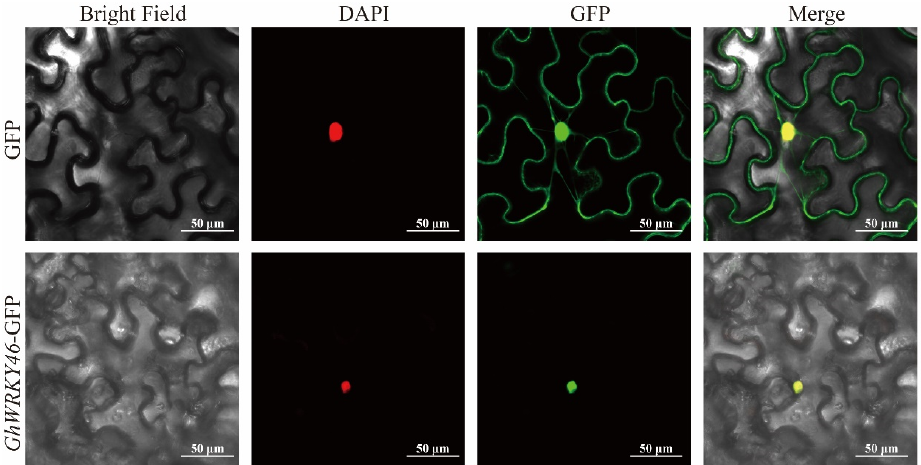
Figure 6. Subcellular localization of the fused GhWRKY46 in tobacco leaf cells. The 121-GFP was used as the control. Nuclear DAPI staining was expressed in the same cell. The scale bar is 5 µm. The cotton lines transformed with the pTRV2:: CLA1 show an albino phenotype, in- dicating that the VIGS experiment was successful (Figures 7b and 8b). The expression level of GhWRKY46 in the silent plants was significantly lower than in the pTRV2:: 00 plants (Figures 7c and 8c). Three weeks later, the silenced and control plants were irrigated with a 400 mM NaCl solution. The results indicate that the silenced plants show a salt- sensitive phenotype after treatment for two days compared with the control (Figure 7a). The MDA content in pTRV2:: GhWRKY46 plants was significantly higher than that in pTRV2:: 00 plants (Figure 8d). For the PEG6000 treatment, we also found that the wilting was more apparent in the leaves of pTRV2:: GhWRKY46 plants than in the pTRV2:: 00 plants under the PEG6000 treatment (Figure 8a). Additionally, the MDA content was higher than that in the control plants (Figure 8d). Our results prove that silencing of the GhWRKY46 can reduce cotton tolerance to salt and PEG-induced drought stresses.